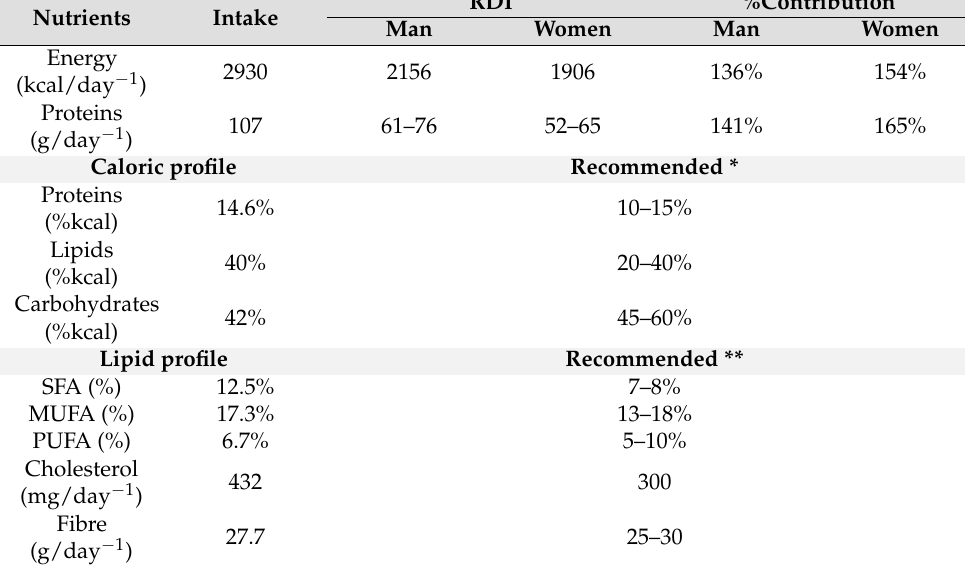
Table 3. Macro-nutrients’ analysis according to estimated real food